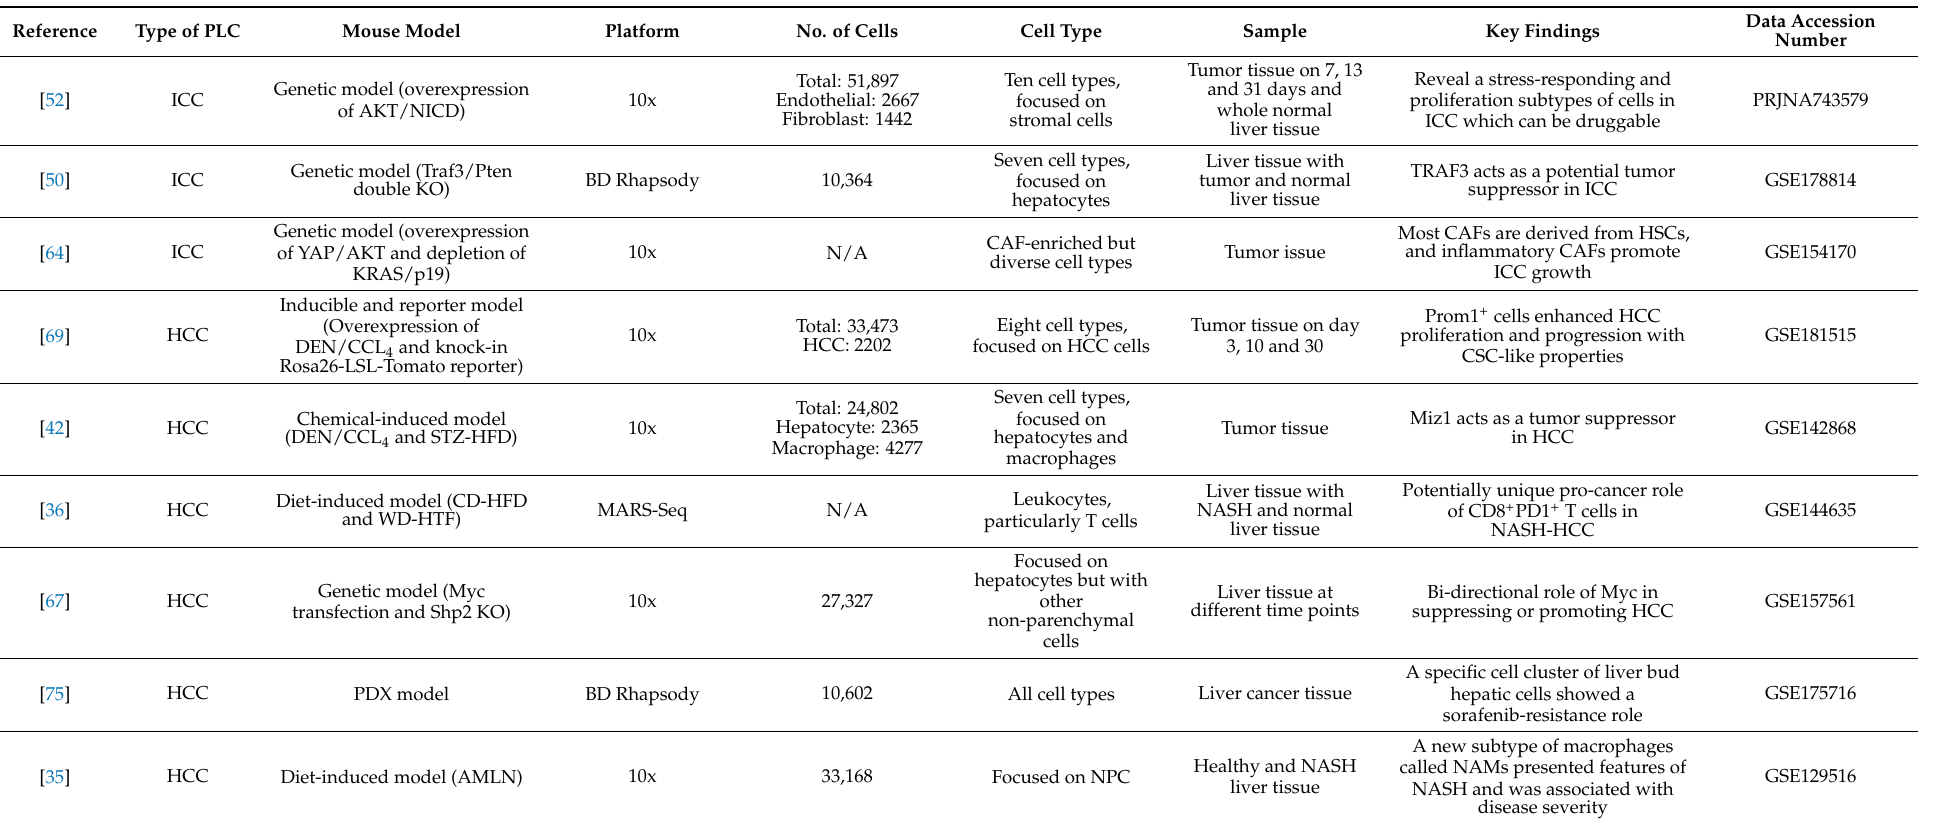
Table 1. Summary of the studies using PLC or NASH pre-clinical mouse models combined with scRNA-seq